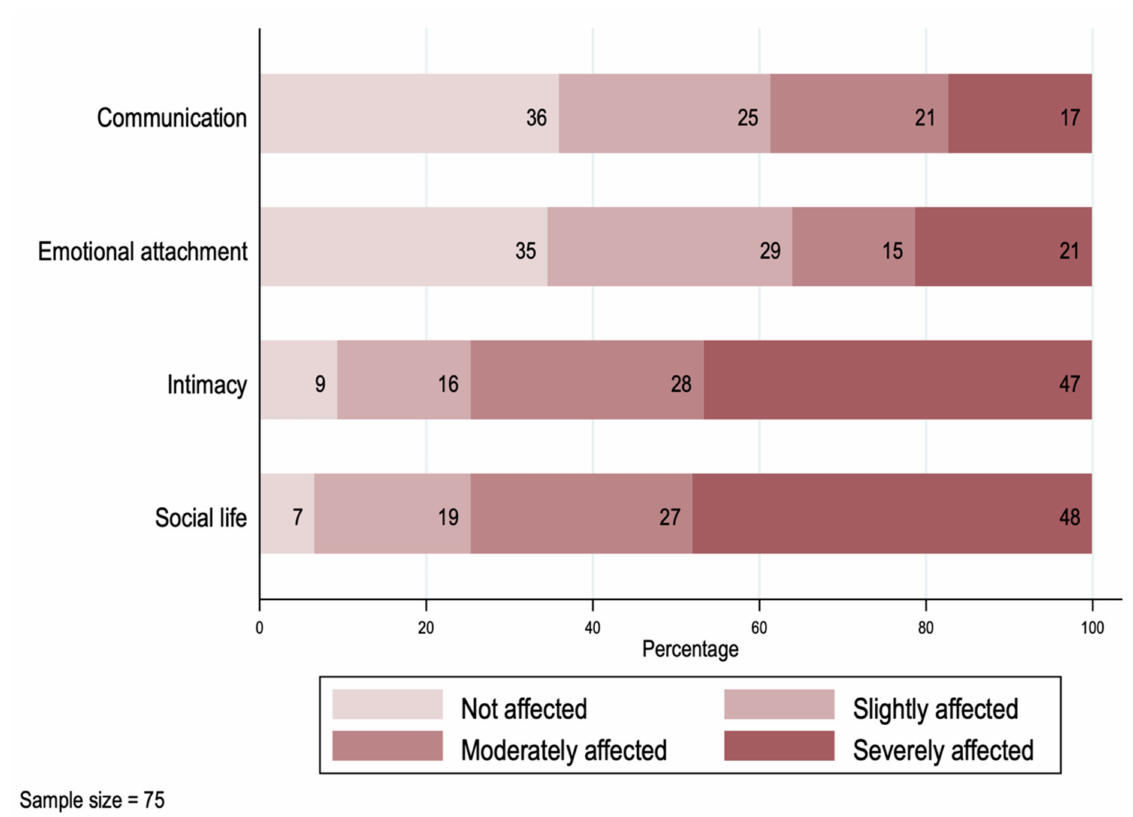
Figure 3. Impact on the primary caregivers’ spouse/partner